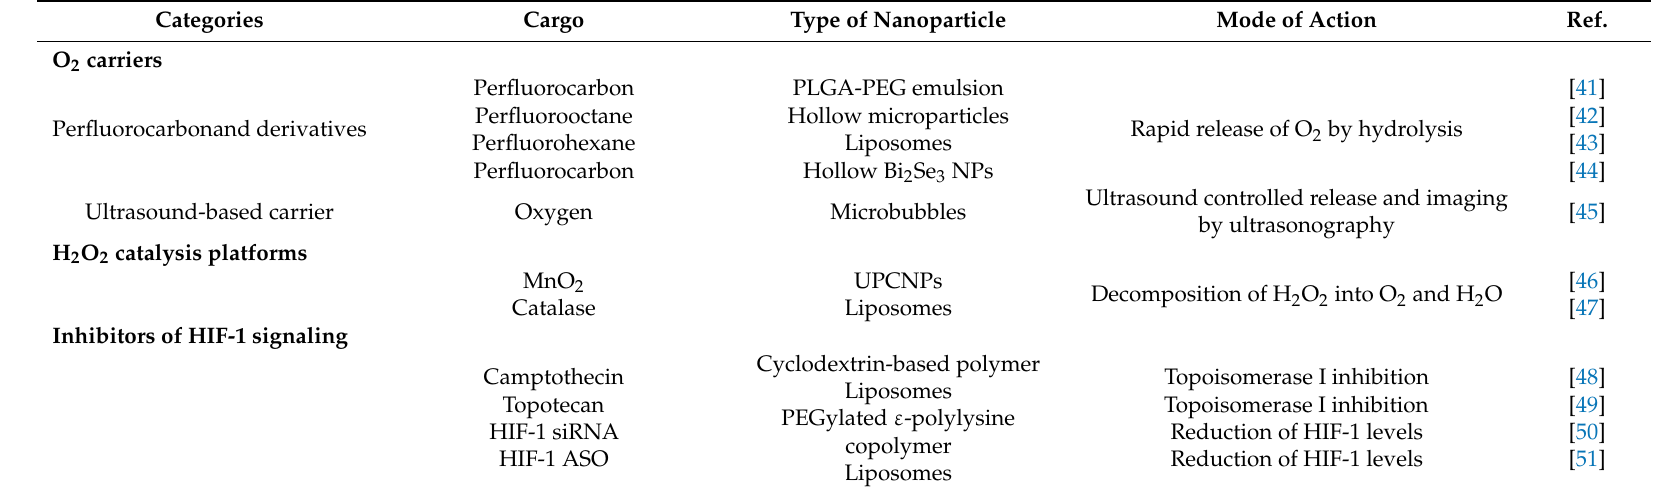
Table 1. Nanotechnology strategies against